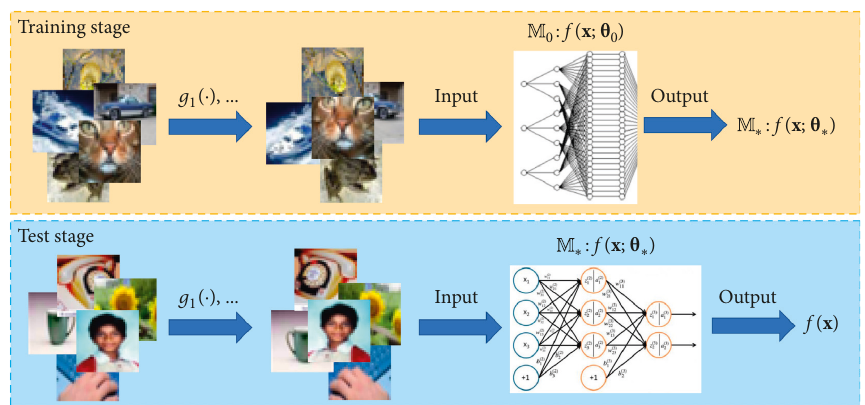
Figure 2: The whole full stage data augmentation framework.